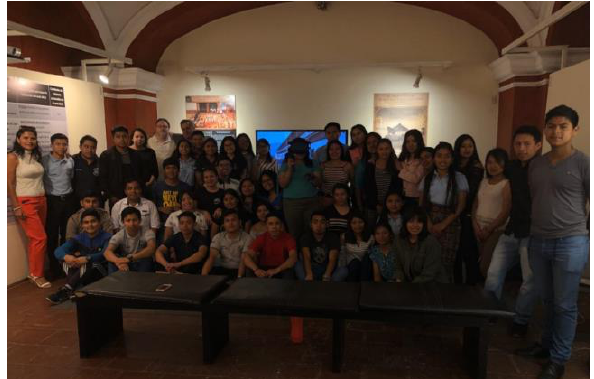
Figure. 11. A group of students on a guided visit to the simulation.